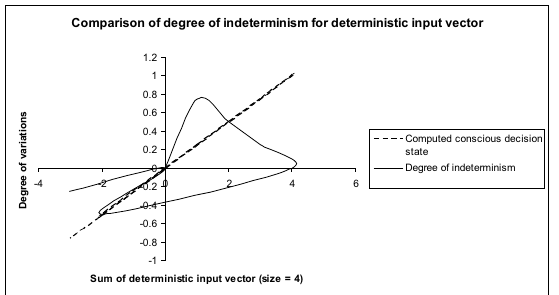
Fig. 14. Variation of state of consciousness in C1 (size = 4). Comparison of degree of indeterminism for combinatorial input vector